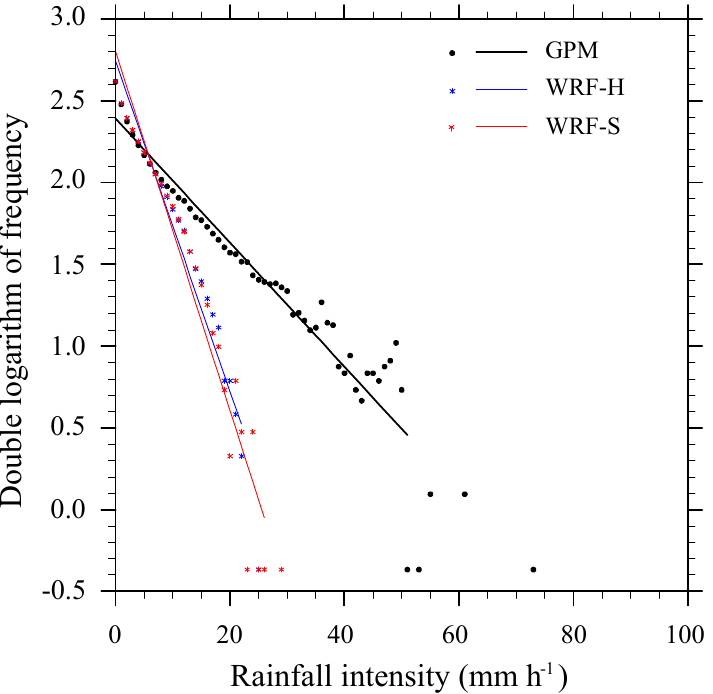
Figure 9. The precipitation frequency over the SRTR is binned by the hourly intensity and its double exponential fit line.